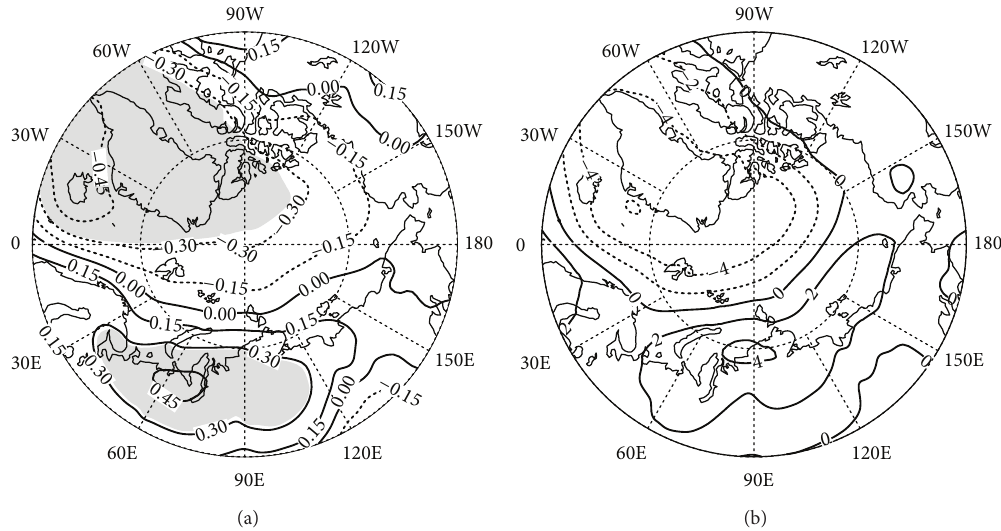
Figure 10: (a) The correlation coefficient distribution between the SLP anomaly in the Arctic region and the total HDs in region A during 1979–2013 summer, and (b) the distribution of the SLP anomaly (hPa) in the summer of 2013. In (a), long-term trend is removed, and shaded area denotes the correlation coefficient significant at the 0.05